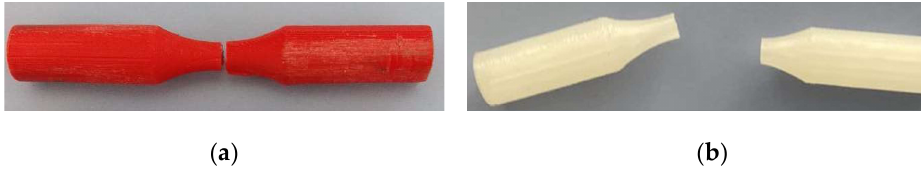
Figure 7. Tested 3D-printed fatigue specimens for ABS ( a ) and Nylon ( b ).